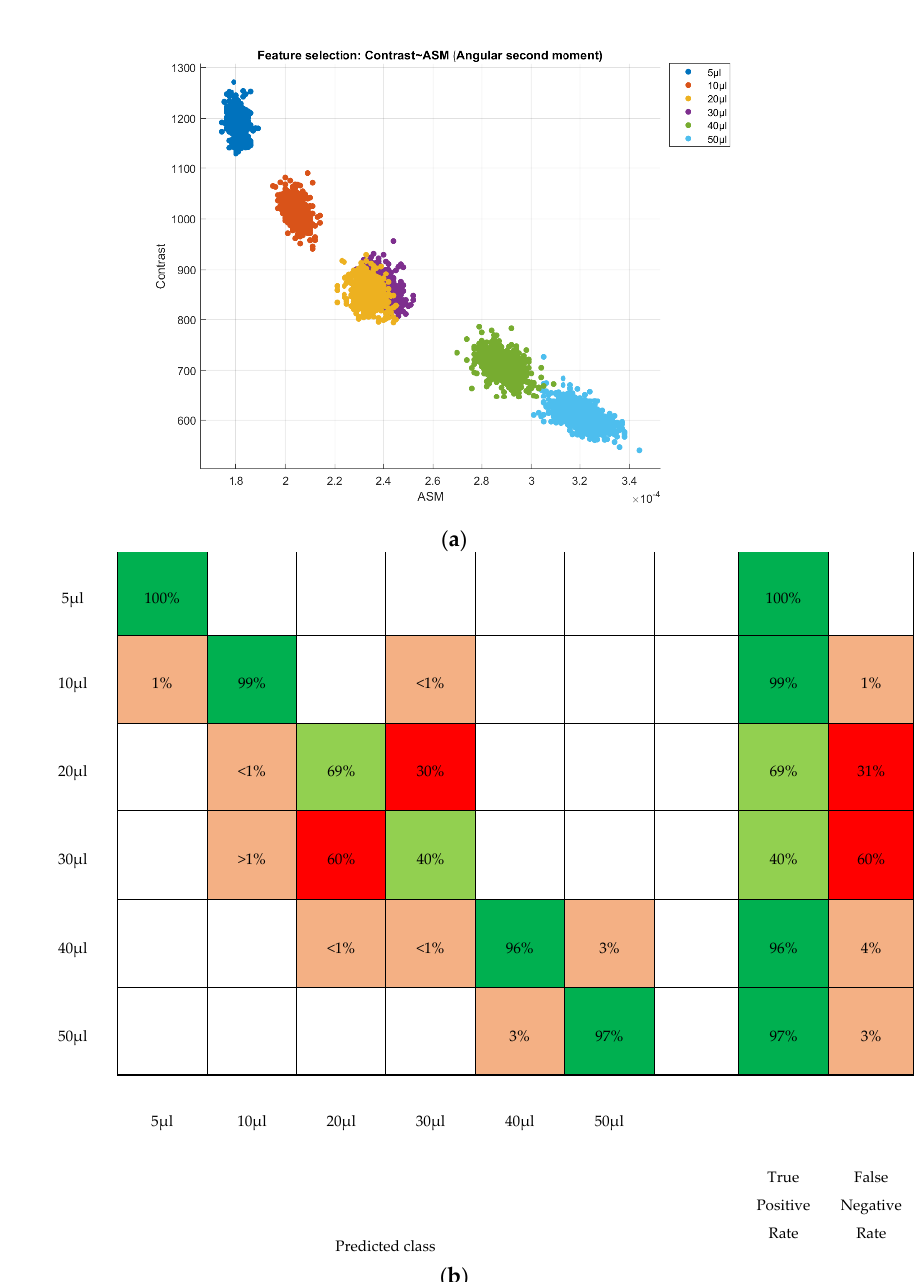
Figure 7. Different concentration of scatterers: ( a )—clusters in the feature space: two most discriminating GLCM features—contrast and angular second moment (ASM)—demonstrated better classification performance; ( b )—confusion matrix.